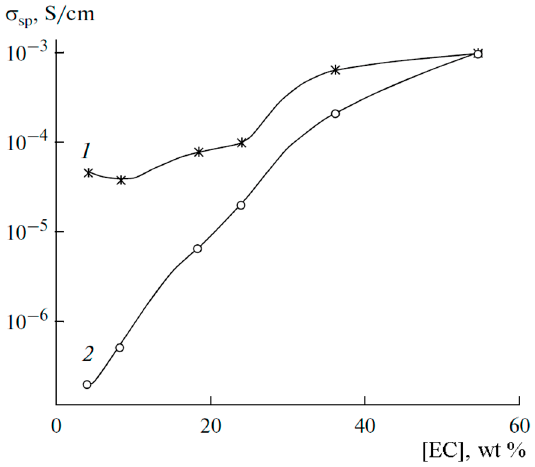
Figure 12. Dependences of the conductivity on the solvent content in PGE at 30 °C: ( 1 ) conductivity calculated by Equation (3), and ( 2 ) conductivity measured by impedancemetry [53].